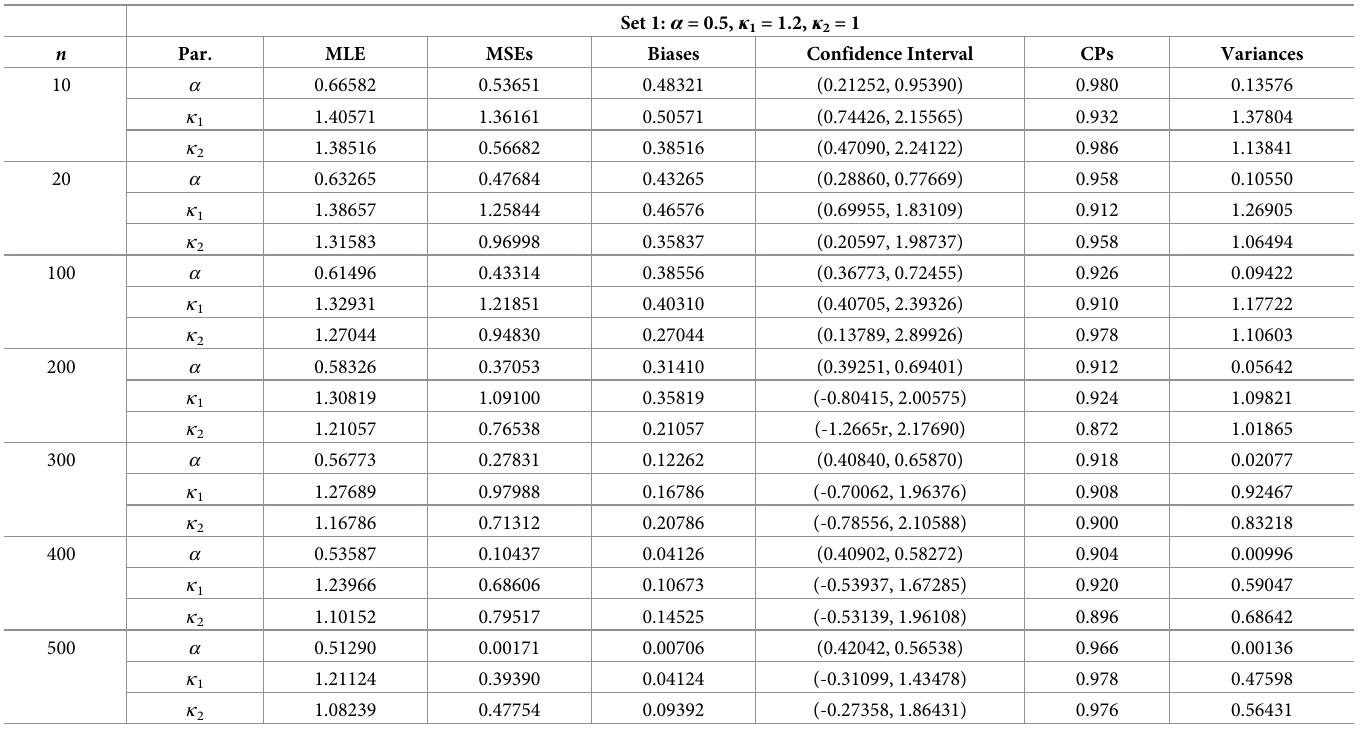
Table 3. The Monte Carlo simulation results of the ASM-Weibull distribution.